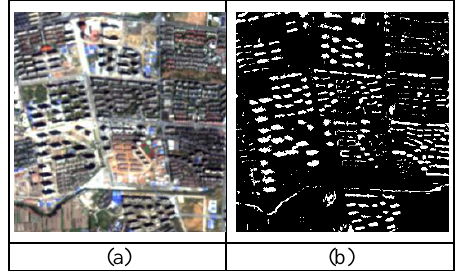
Figure 11. An example of shadow extraction results (a) original image; (b) extraction result